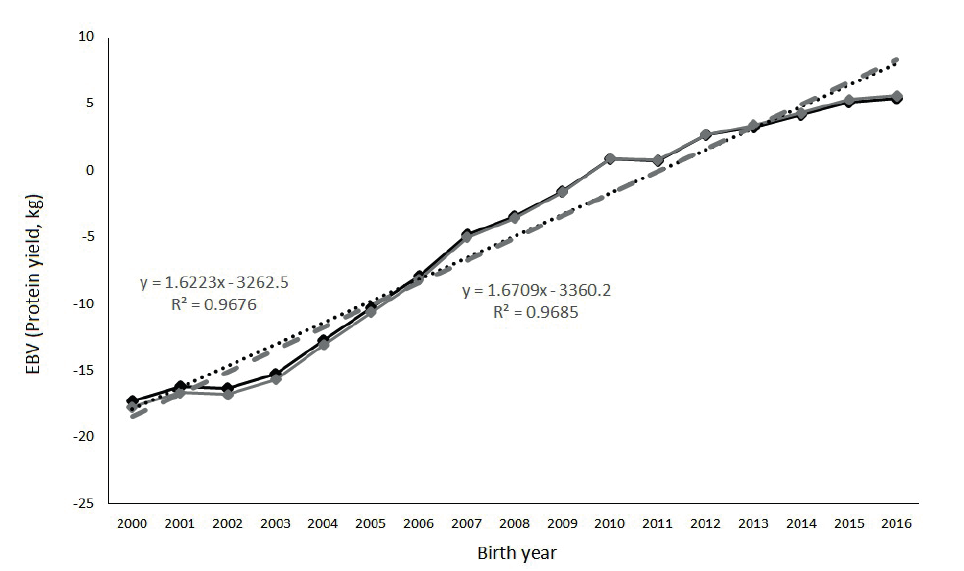
animalsFig. 3. Obtained genetic trend in protein yield for cows and corresponding regression lines with equation showing annual response using a single-lactation model (black lines) or a multi-lactation model (gray